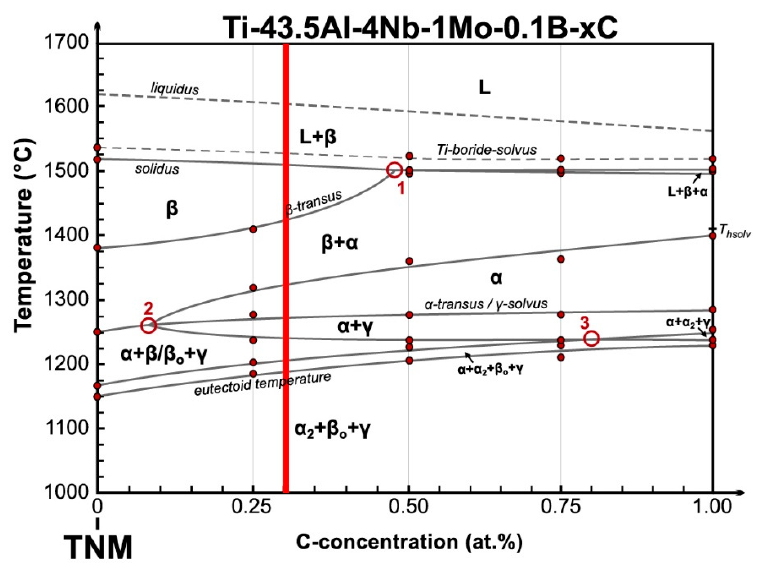
Figure 11. Quasi-binary phase diagram of the Ti-43.5Al-4Nb-1Mo-0.1B-xC (at.%) system as deter- mined by Schwaighofer et al. [24]. The red line indicates the C content of the studied TNM + alloy. Adapted with permission from Ref. [24].